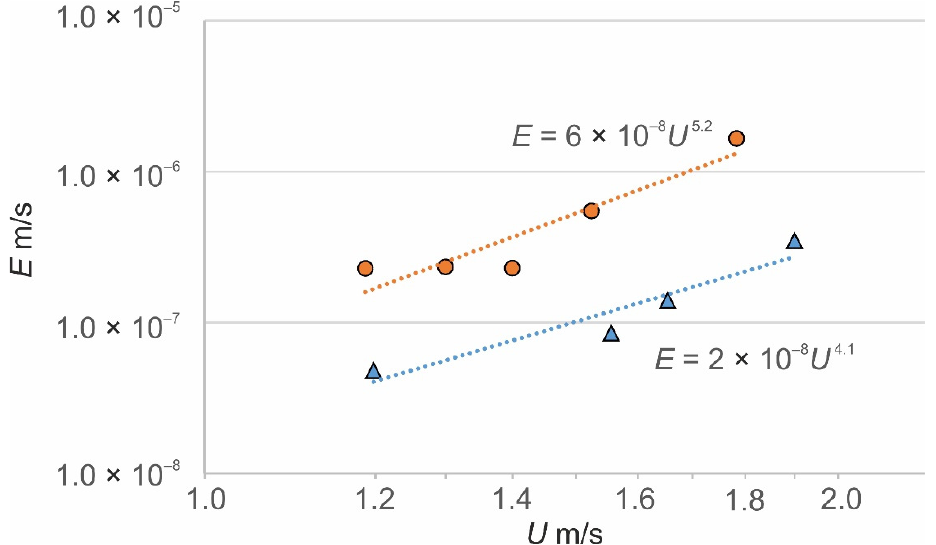
the experiments with the cutting of the surface of the soil sample with a moving blade [24]. The relationship between the erosion rate and the flow velocity shows a higher erosion rate at plot 1 than at plot 2 for the same velocity (Figure 3). This is explained by the higher soil aggregate stability and organic matter content in the soil at plot 2. The power–law functions describe these relationships well. The exponents are different for these two plots (5.2 for the first and 4.1 for the second) and differ from the function commonly used in the majority of shear–stress erosion models (see, for example, [27]).